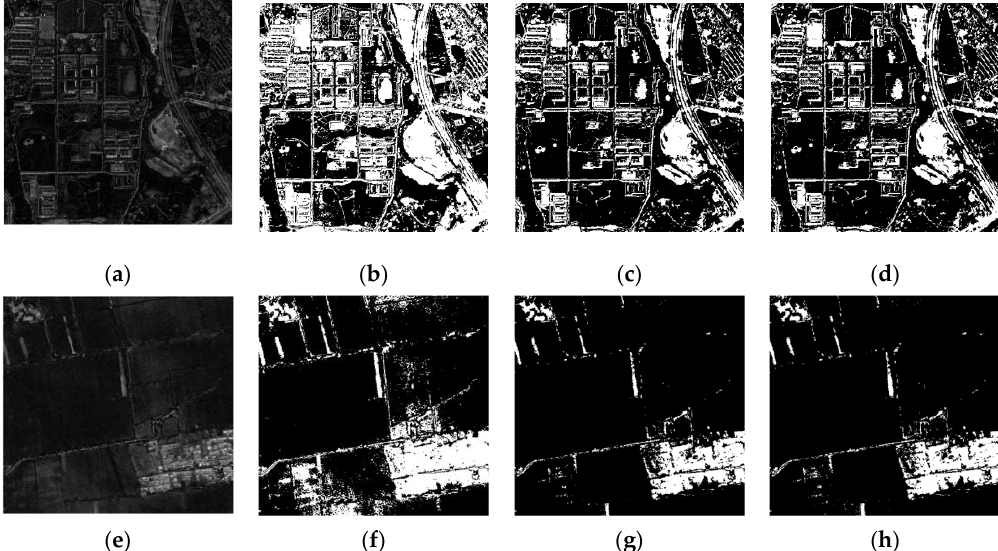
Figure 6. The change magnitude images and binary change maps obtained by CVA. ( a , e ) denote change magnitude images for the first data and the second data set, respectively. ( b – d ) are binary change maps for the first data set generated by CVA-EM, CVA-FCM. and CVA-Kmeans, respectively. ( f – h ) are binary change maps for the second data set generated by CVA-EM, CVA-FCM, and CVA-Kmeans, respectively.